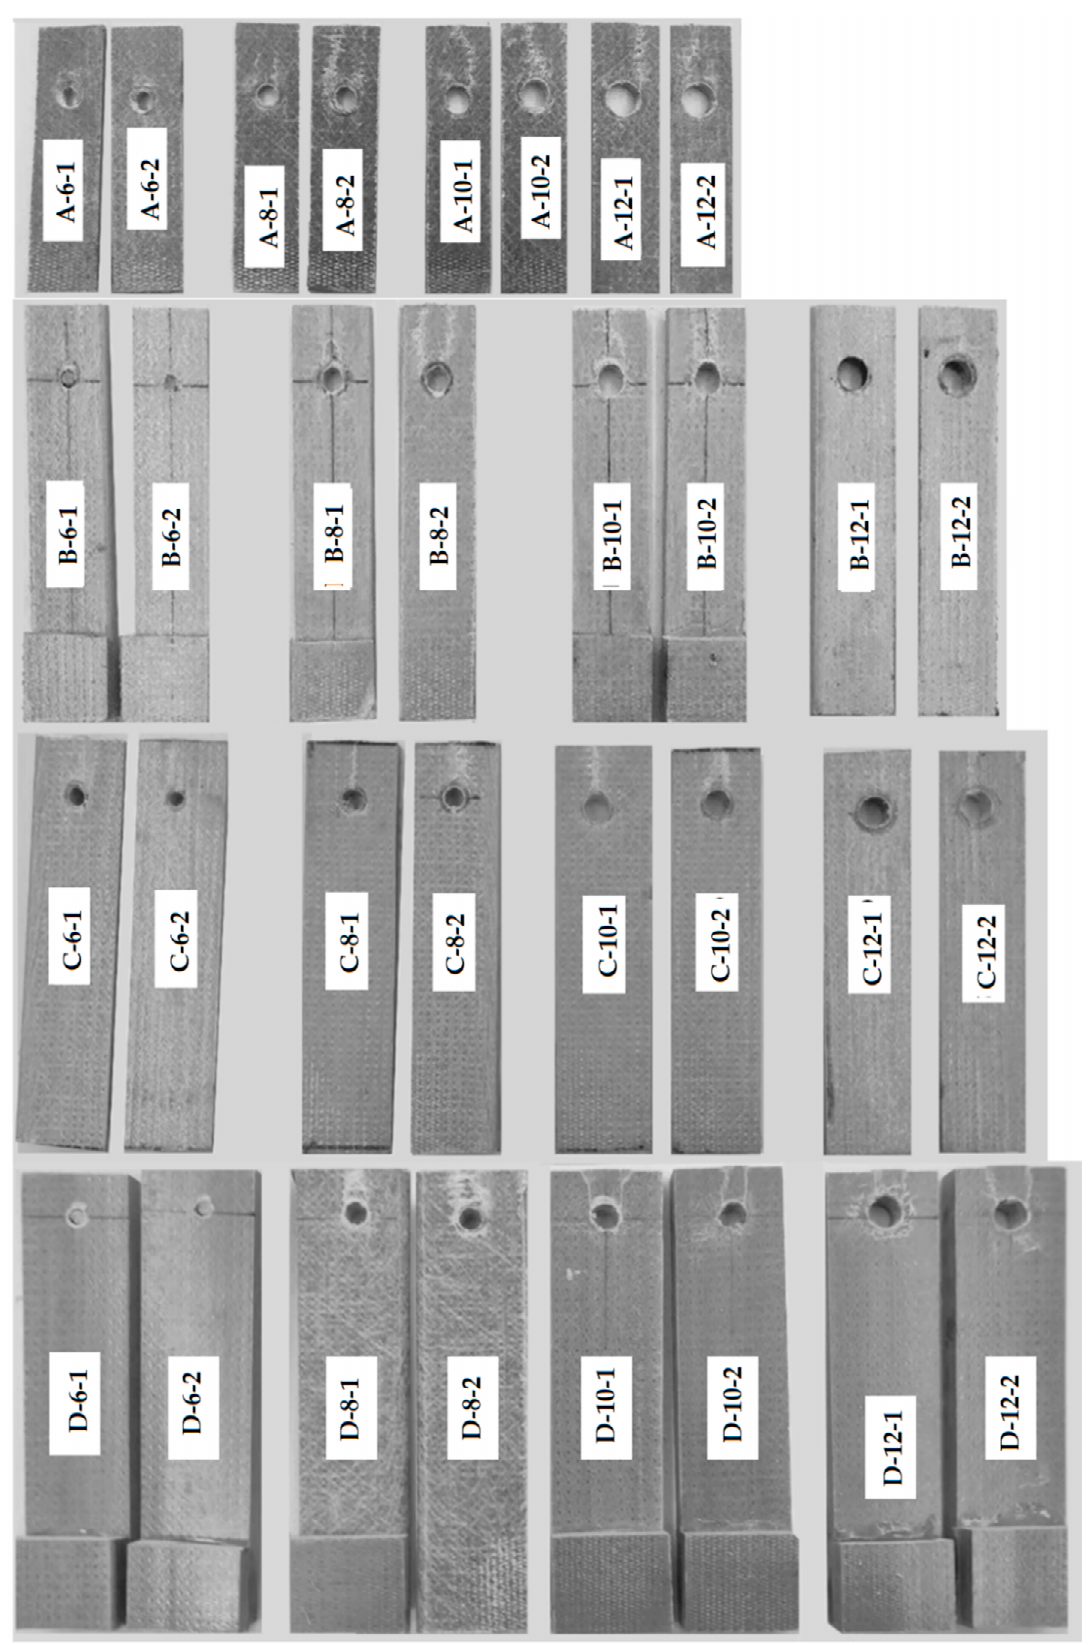
Figure 5. Failure patterns of the selected joints (scaled to represent actual size).